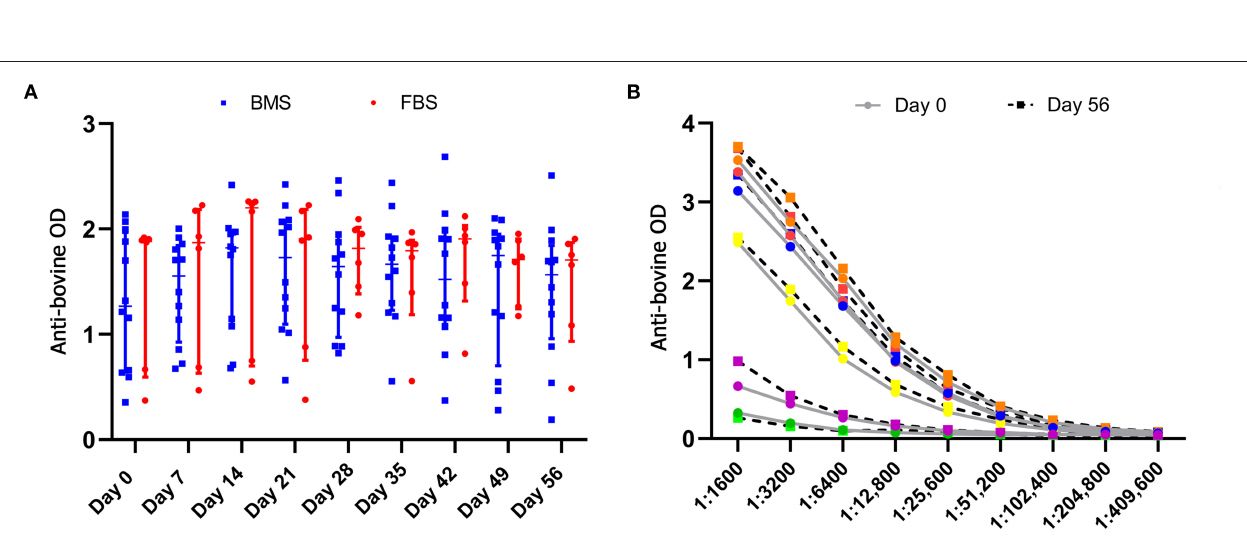
Frontiers in Veterinary Science |